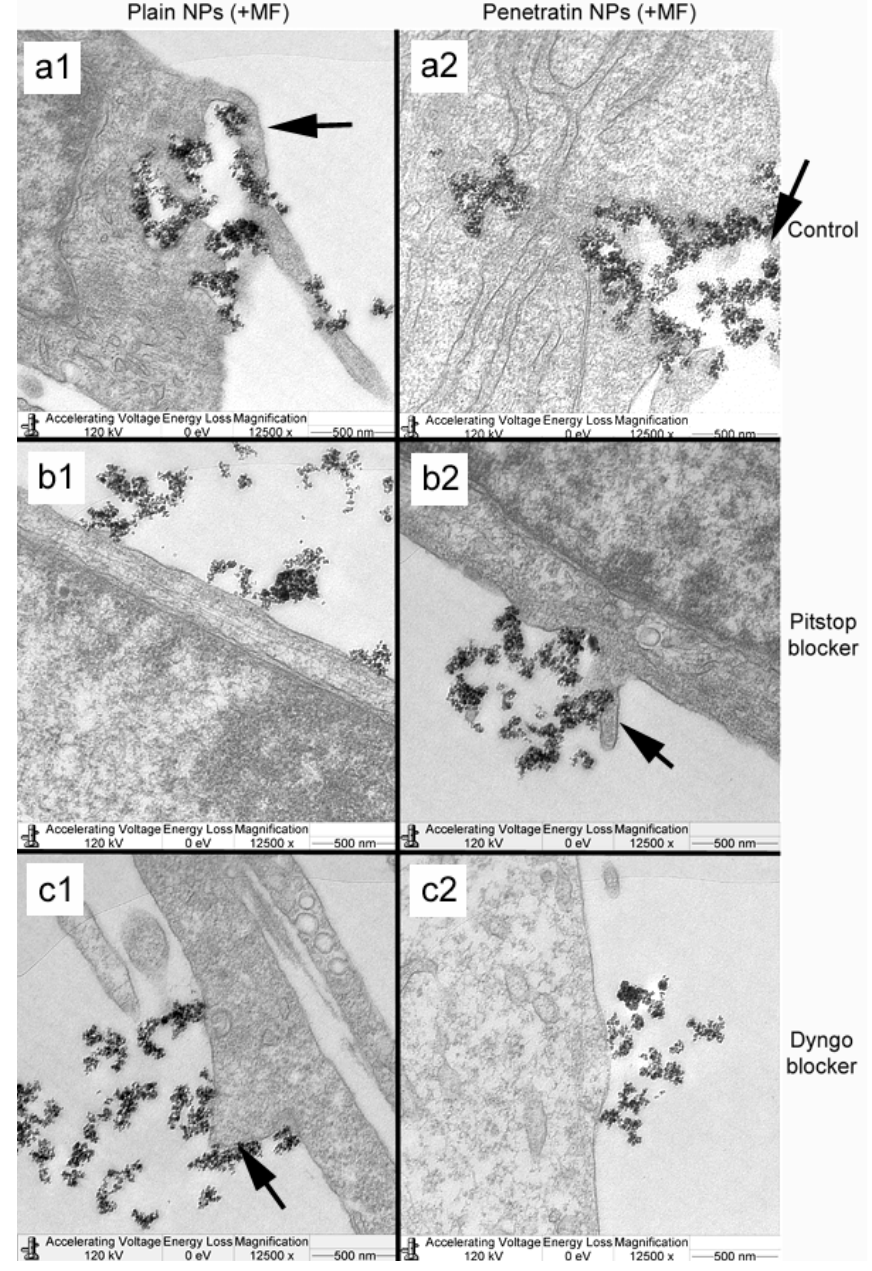
10. TEM micrographs showing cellular uptake of plain and penetratin functionalised NPs in the presence of a magnetic field. Control cells (no blockers; a1 and a2), cells incubated in Pitstop (b1 and b2) and cells incubated in Dyngo (c1 and c2). Note the appearance of membrane extrusions, particularly in the control cells, indicative of pinocytosis (black